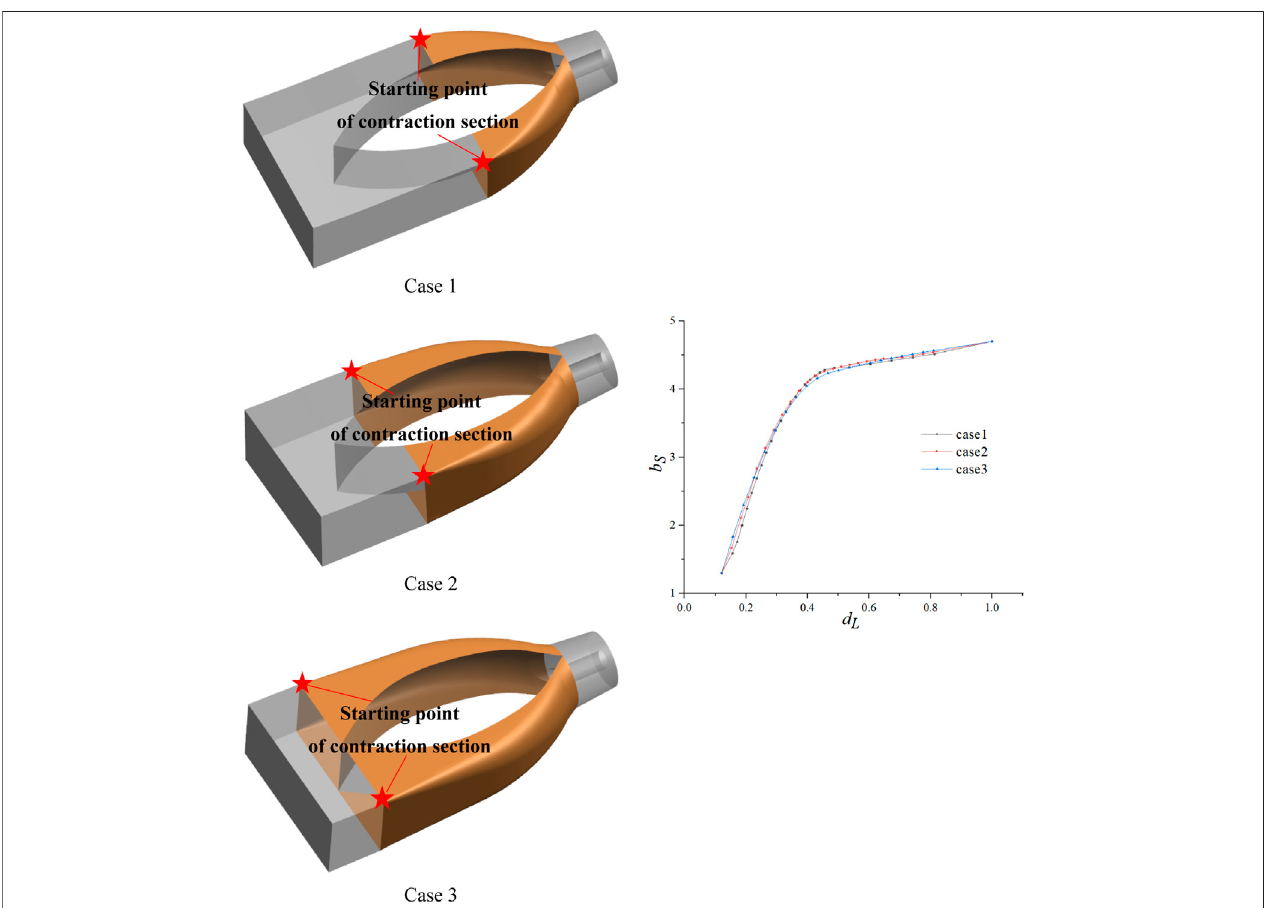
FIGURE 5 | Cross-sectional area of the variation curve of the inlet passage for each